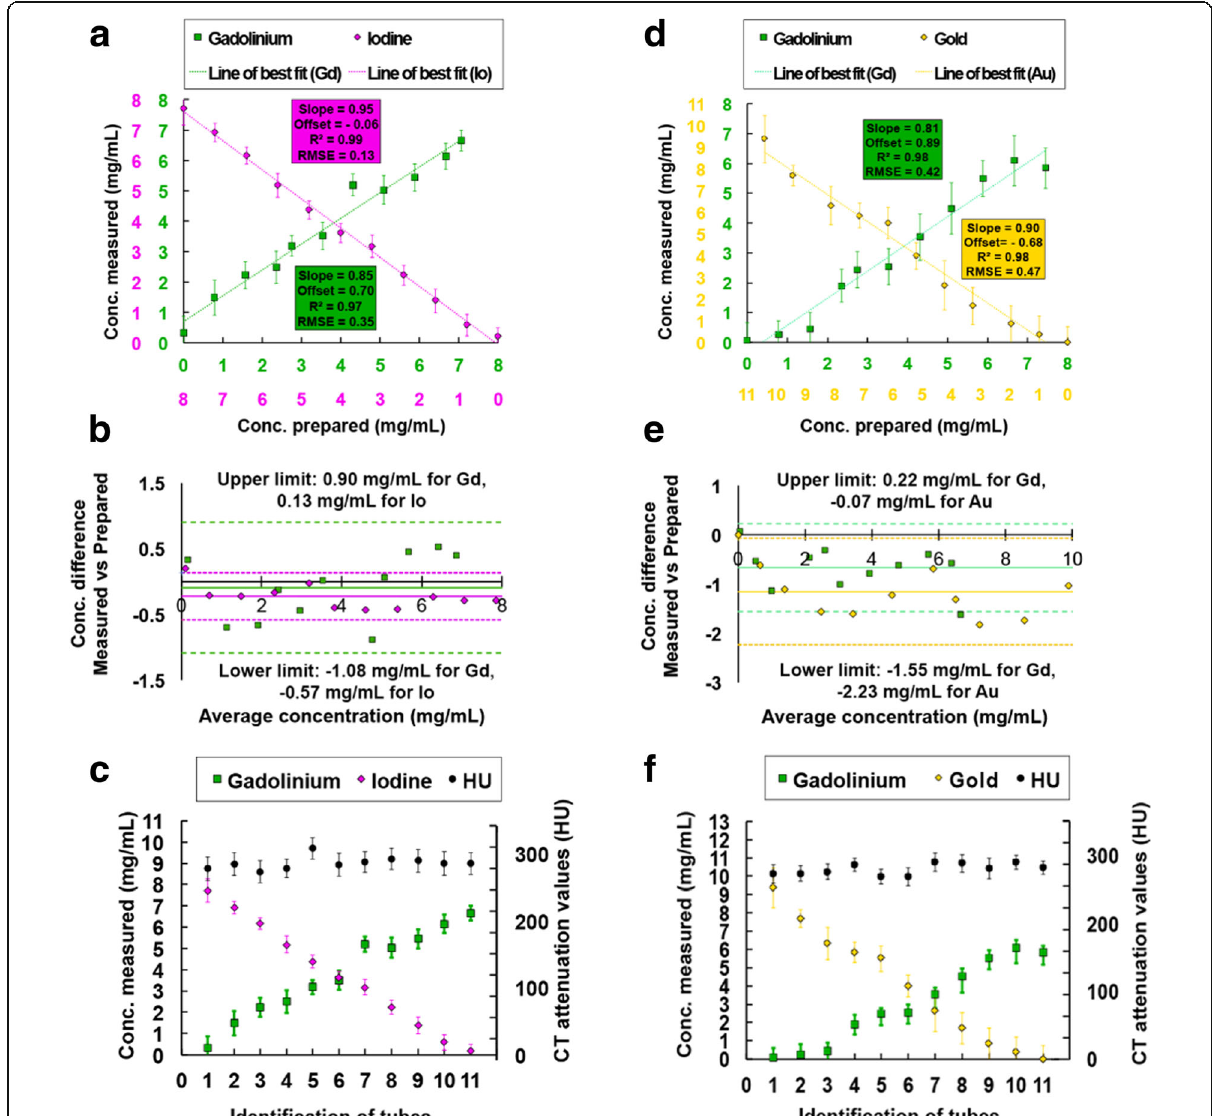
Fig. 4 Measurements of the concentrations of contrast agents and attenuation values in the mixed solutions. The concentrations of each contrast agent were measured within the gadolinium – iodine ( a , b , c ) and gadolinium – gold ( d , e , f ) mixtures. a , d Linear regression; b , e : Bland – Altman analysis; c , f : graphs of the mean ± standard deviation of attenuation values and concentrations. Note that, as expected, the measured concentrations in the tubes varied inversely between the two mixed contrast agents